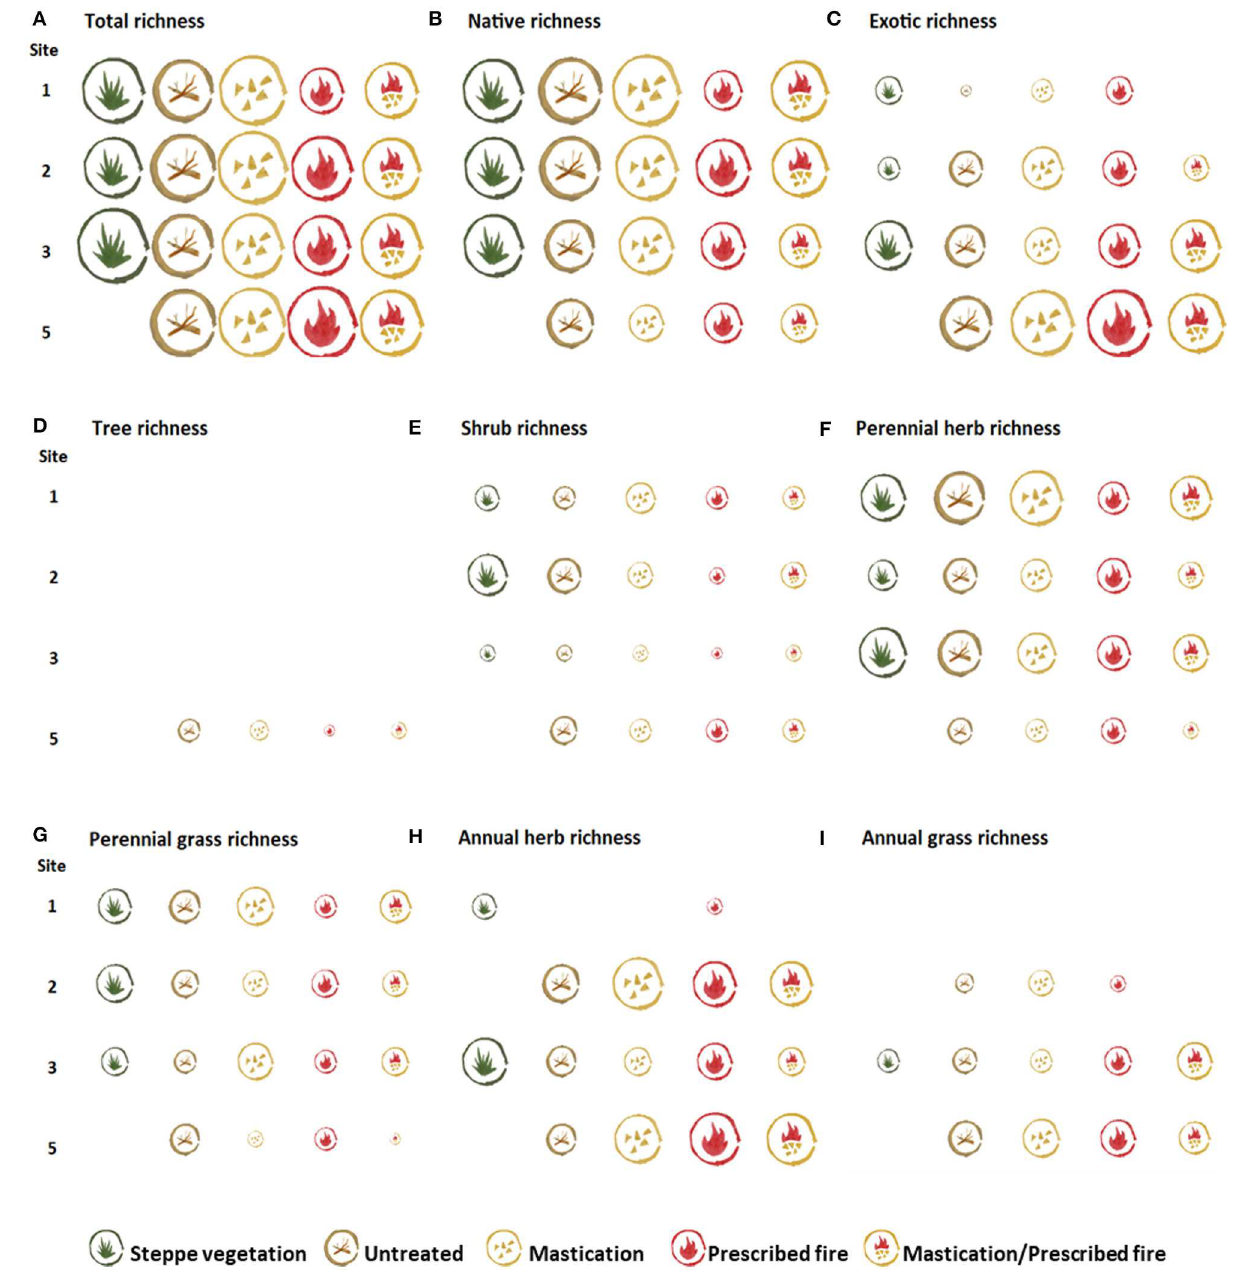
FIGURE 8 | Representation of total richness (A) , and by origin (B,C) and growth form (D–I) , in the steppe vegetation and fuel treatments the last sampling year in each study site. Icon size corresponds to variables’ mean value (ranging from 0.25 to 11.50 species/4m 2 ) for each treatment.